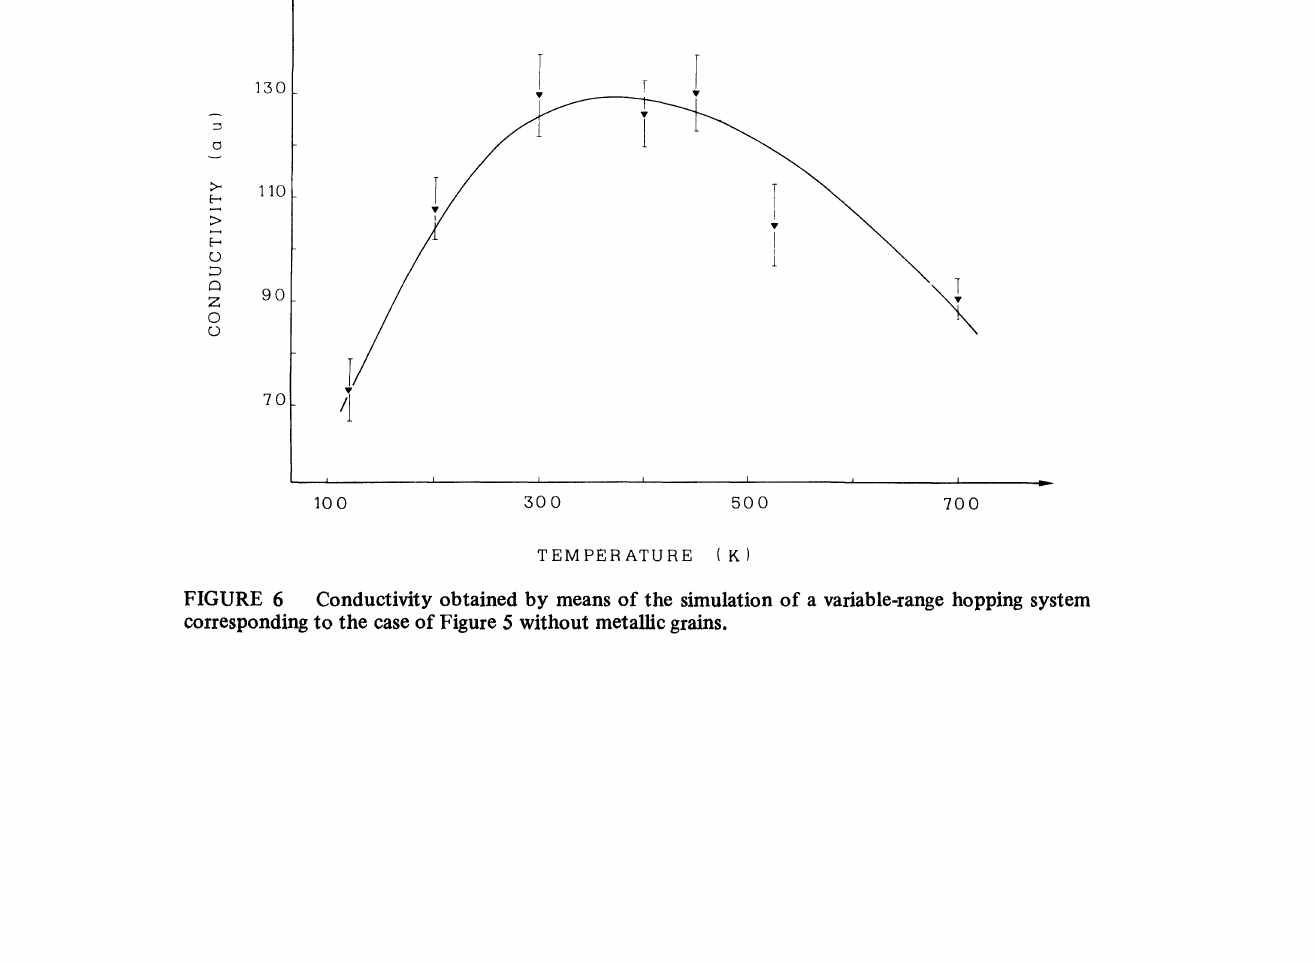
Conductivity of a model TFR obtained by means of the simulation with the physical parameters indicated in the text.